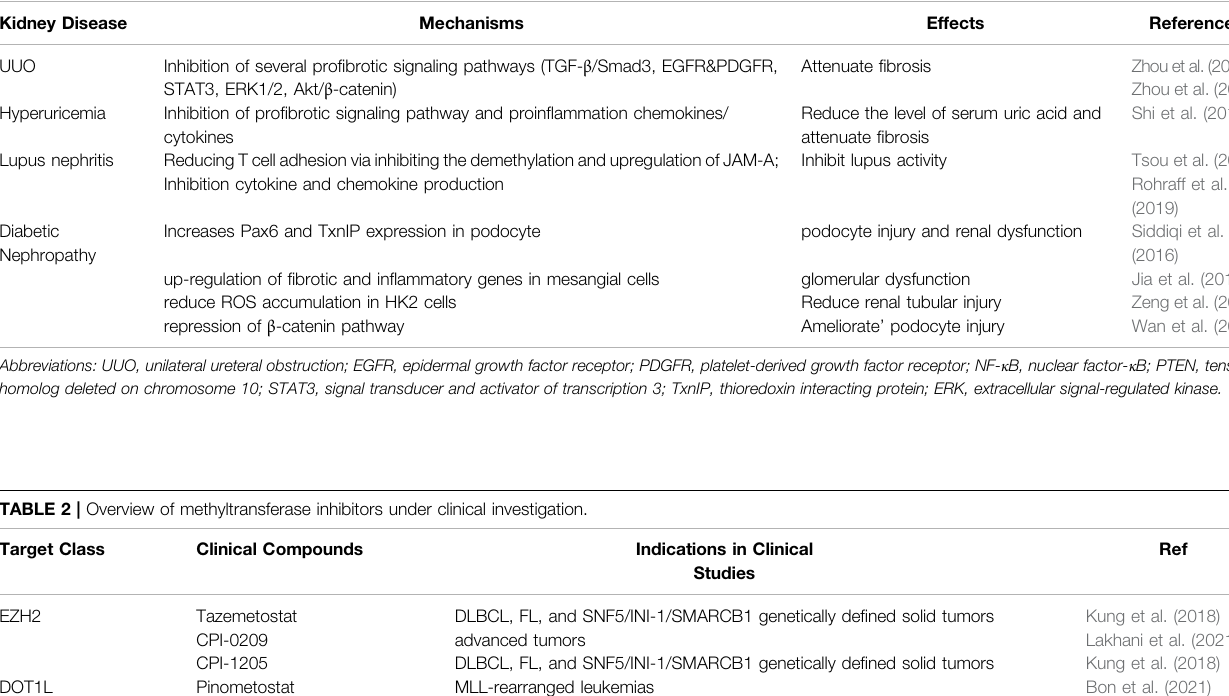
TABLE 1 | EZH2 inhibition on various chronic kidney diseases.